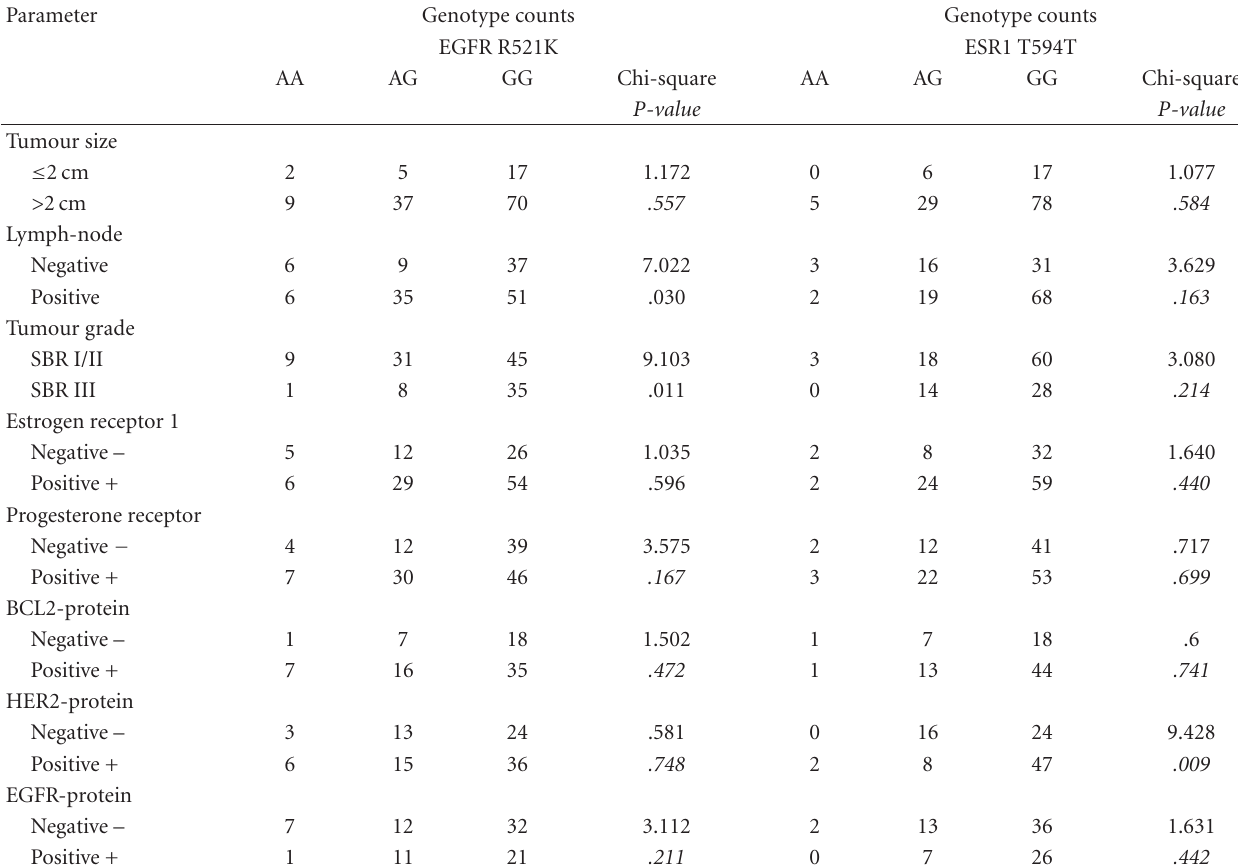
Table 3: Association between EGFR and ESR1 genotype with EGFR, HER2, ER, PR, and BCL2 protein expression and clinical parameters.